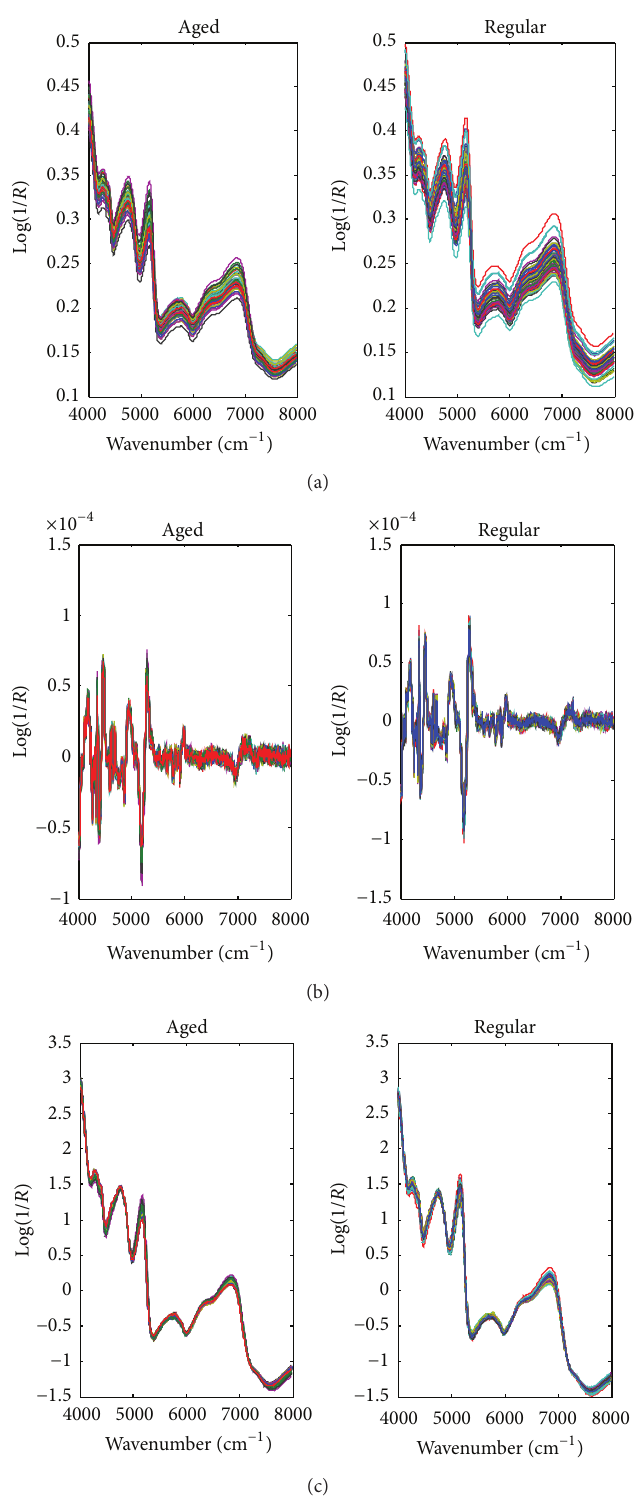
Figure 3: Preprocessed NIR spectra of regular and aged shiitake preprocessed by smoothing (a), SNV taking D2 (b), and SNV